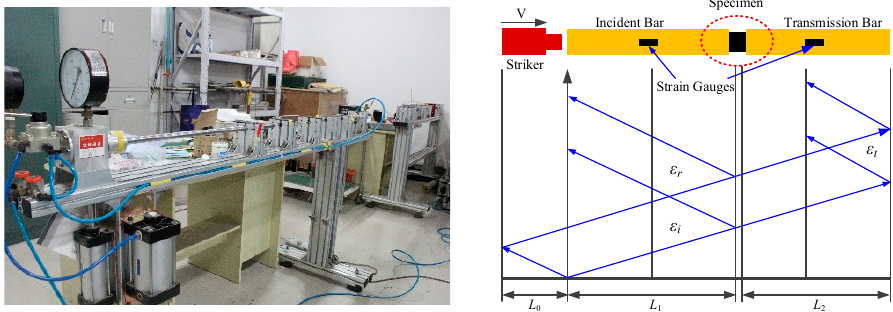
Figure 1. Schematic diagram of split Hopkinson compression bar device and stress wave transmis- sion.